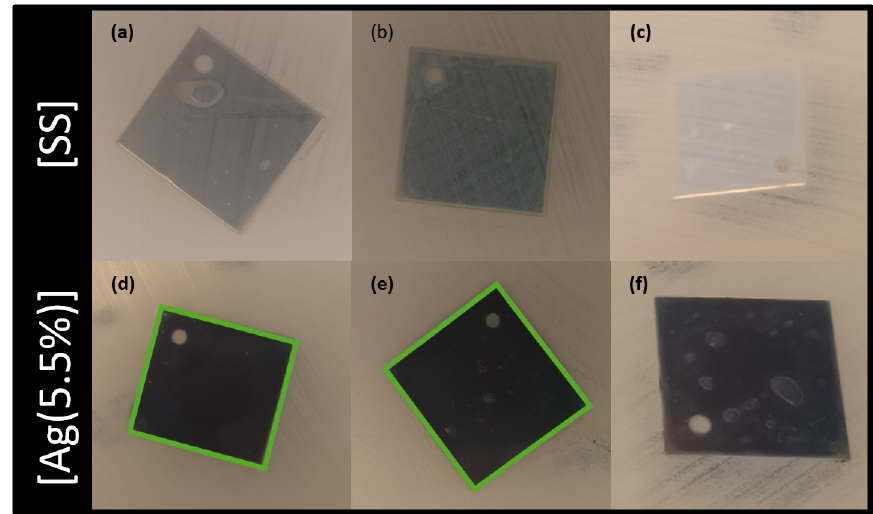
Figure 7. Optical micrographs of the modified antibiotic tests after multiple exposures: first column = first exposure; second column = second exposure, and third column = third exposure. Images ( a – c ) are associated with [SS] and ( d – f ) with [Ag(5.5%)]. The square size is 20 × 20 mm. [SS] = stainless steel coupons (CTRL); [Ag(5.5%)] = the carbon matrix containing 5.5% of Ag in the bulk and 6.5% of Ag at the surface.